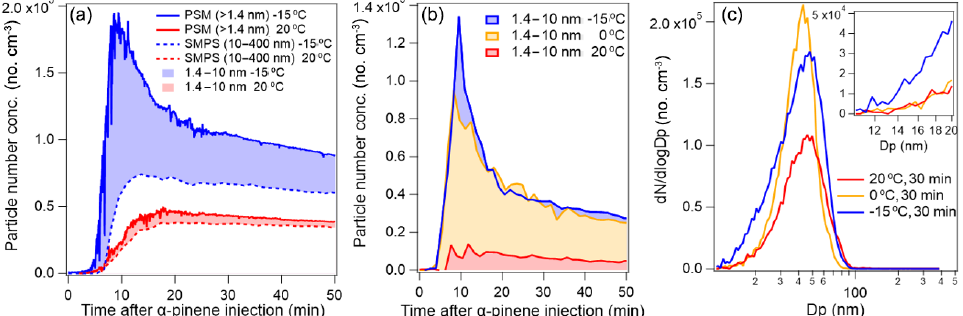
Figure 4. (a) Effect of temperature on particle number concentrations (no.cm − 3 ) as derived from the SMPS (10–400nm particle size range; broken line) and PSM ( > 1 . 4nm particle size range; solid line) in experiments with an initial α -pinene concentration of 10ppb. (Exp. 1.1, red; Exp. 1.3, blue). (b) Particle number concentrations (no.cm − 3 ) of 1.4–10nm particles in experiments with an initial α -pinene concentration of 10ppb performed at − 15, 0, and 20 ◦ C (Exp. 1.1, 1.2, and 1.3, respectively). (c) Particle size distributions recorded 30min after